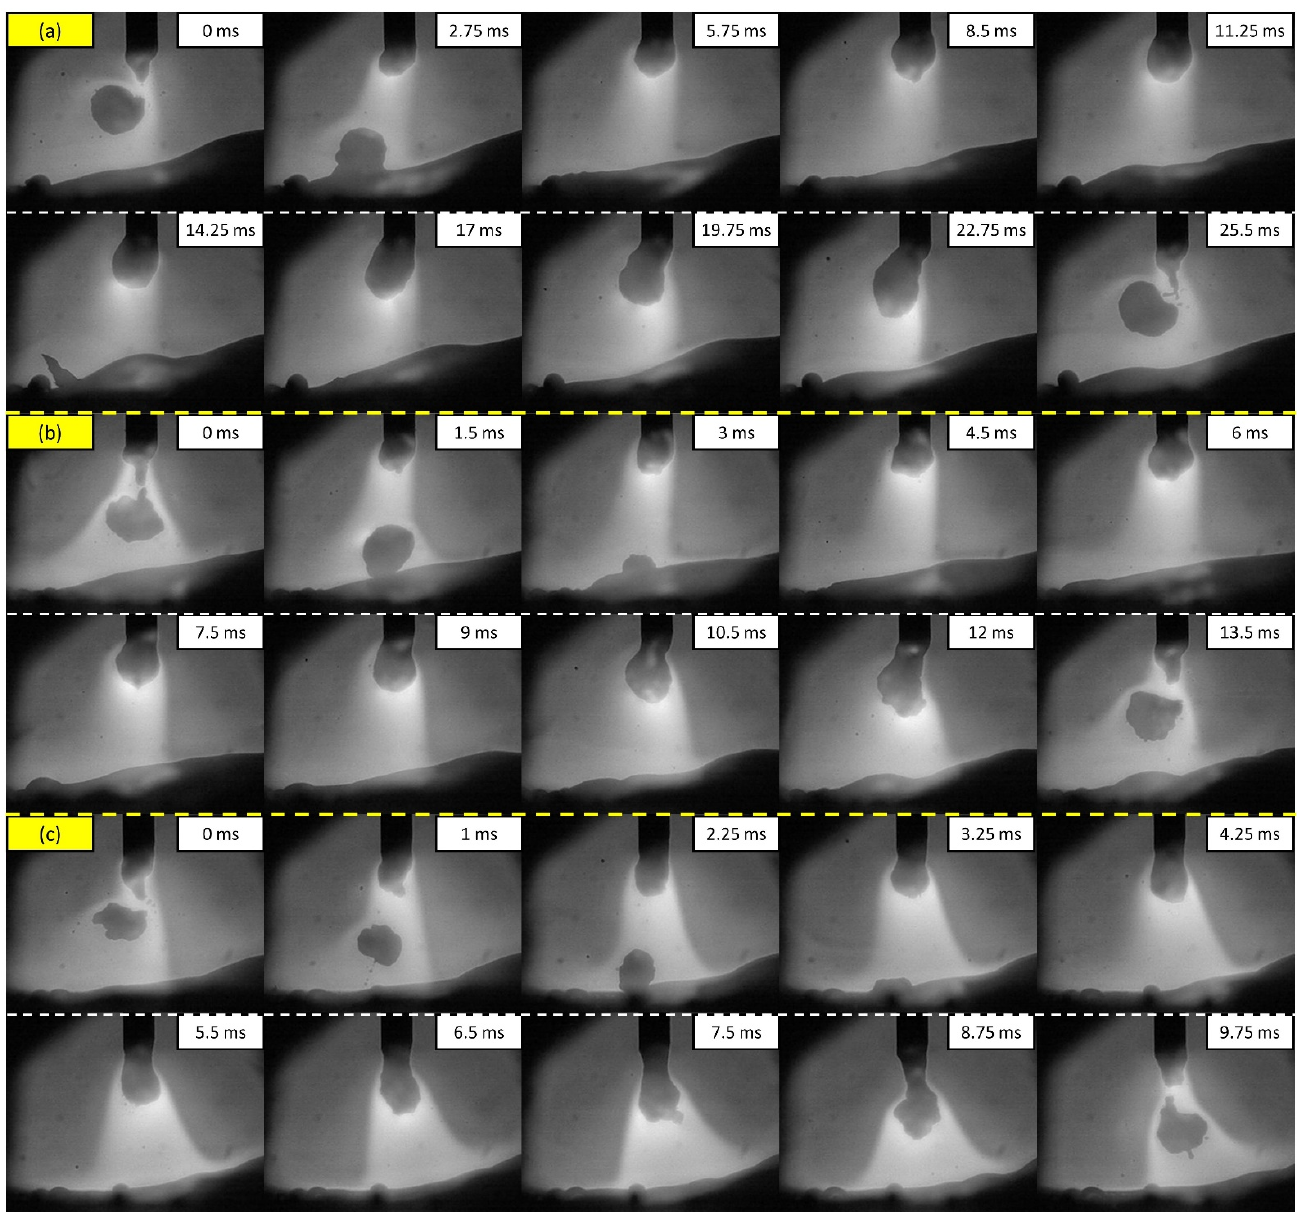
Figure 3. Sequential images of metal transfer in metal ‐ cored wire in 220 A ( a ), 250 A ( b ), and 280 A ( c ) of welding current.